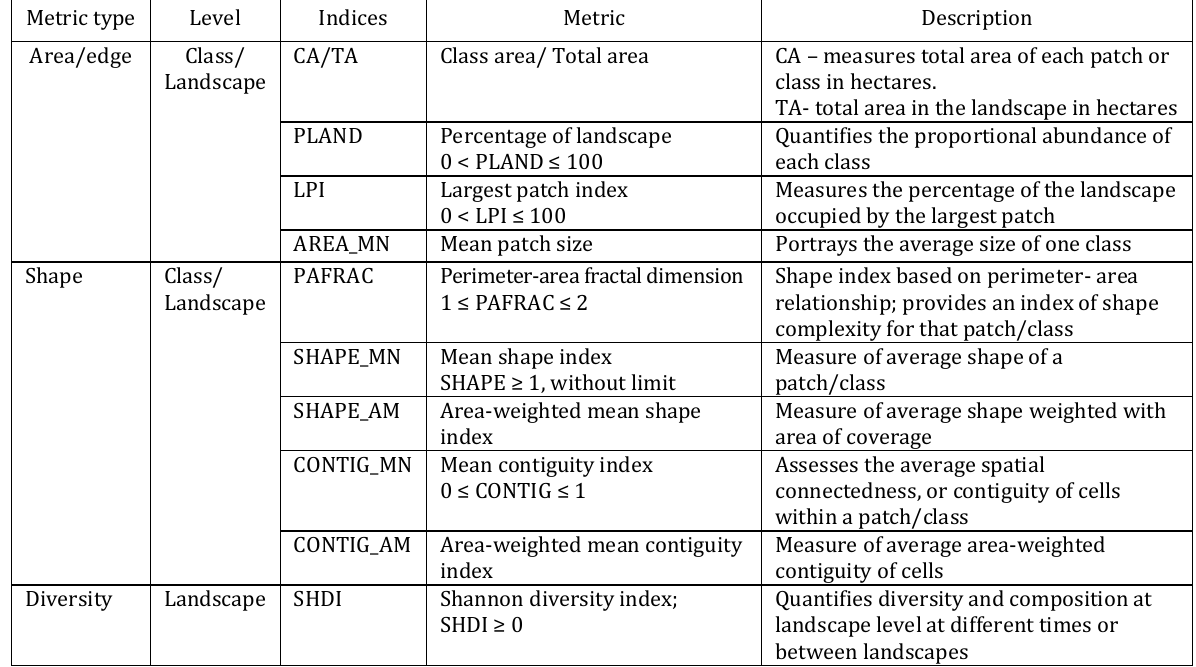
Table 1. Description of landscape metrics computed for class and landscape levels (Source: McGarigal et al., 2012) Metric